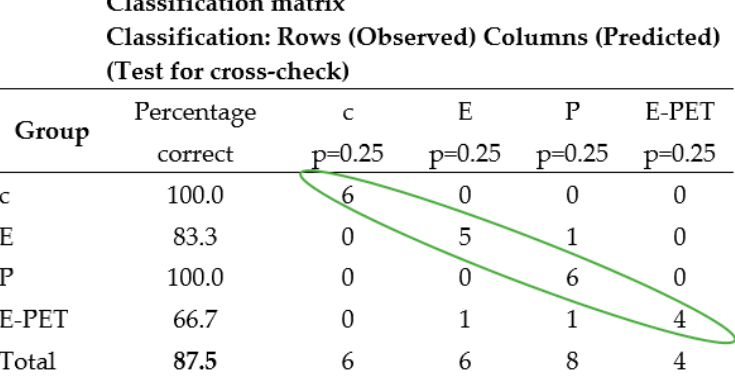
Figure 7. Classification matrix—test group.